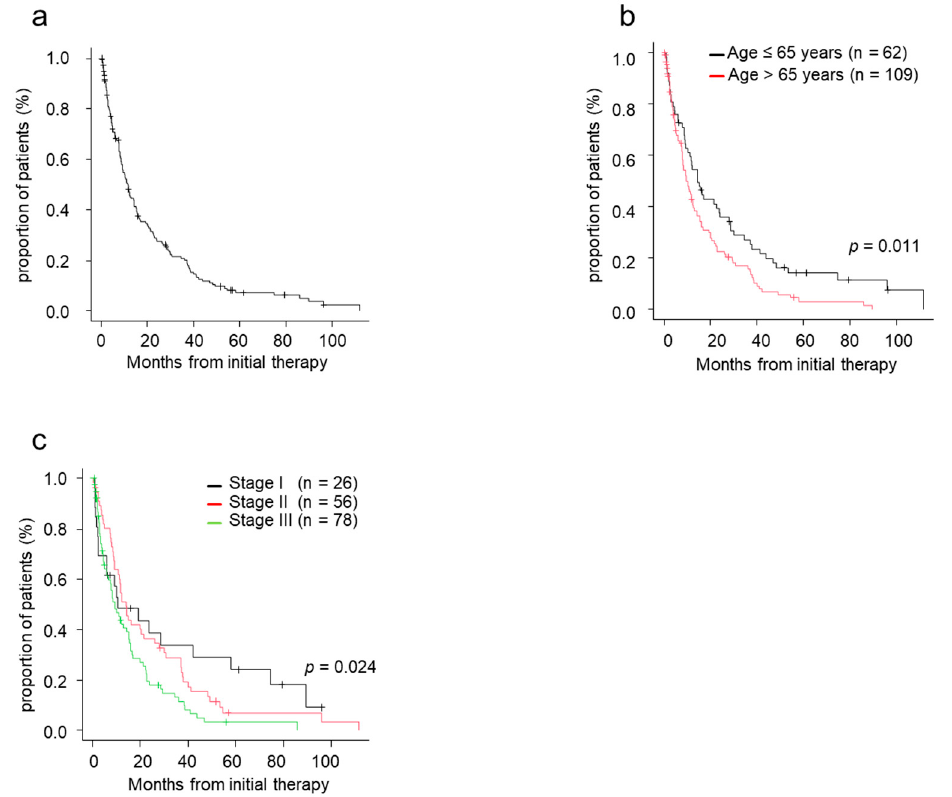
Figure 1. Time to next treatment (TTNT) by patient characteristics. ( a ) TTNT from initial therapy. ( b ) TTNT from initial therapy by age. ( c ) TTNT from initial therapy by ISS stage. ISS, International Staging System; TTNT, time to next treatment.